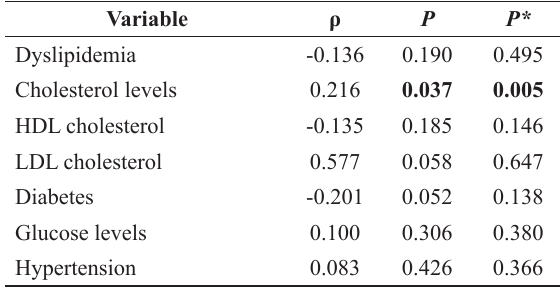
Correlation between ferritin levels and clinical aspects and laboratory